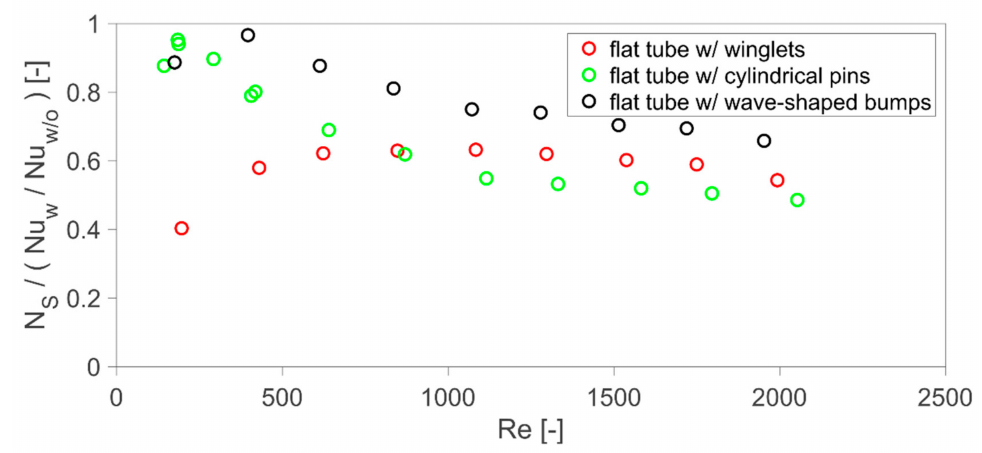
Figure 17. Extended efficiency criterion PEC according to Zimparov [37] for Pr =